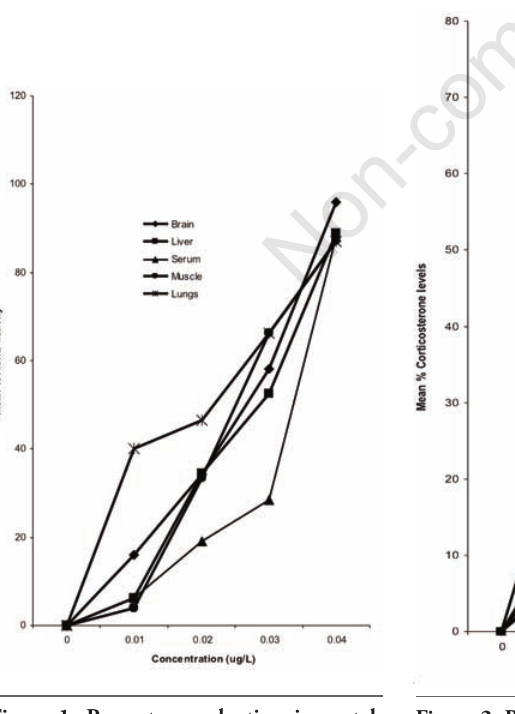
Figure 2. Percentage reduction in corticos- terone levels in organ/tissues of B ufo regu- laris exposed to diazinon for 28